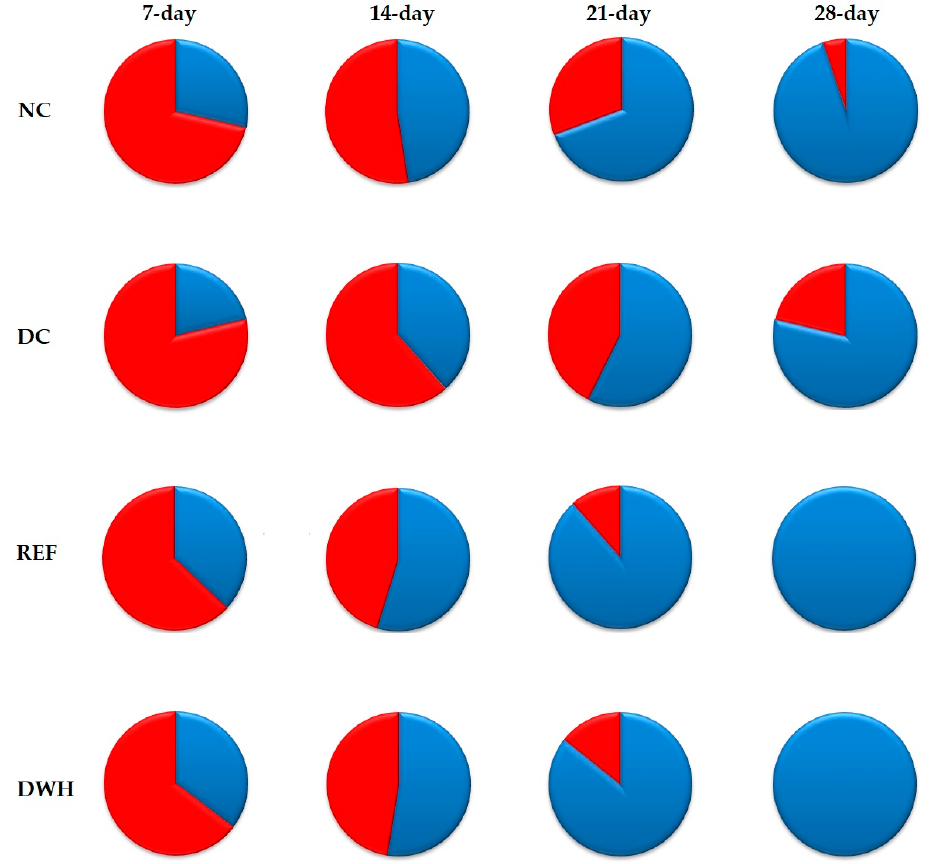
Figure 11. Effect of topical application of 2% Fucidin cream (REF) and 2% DWH gel on the percentages of wound contractions in diabetic rats.